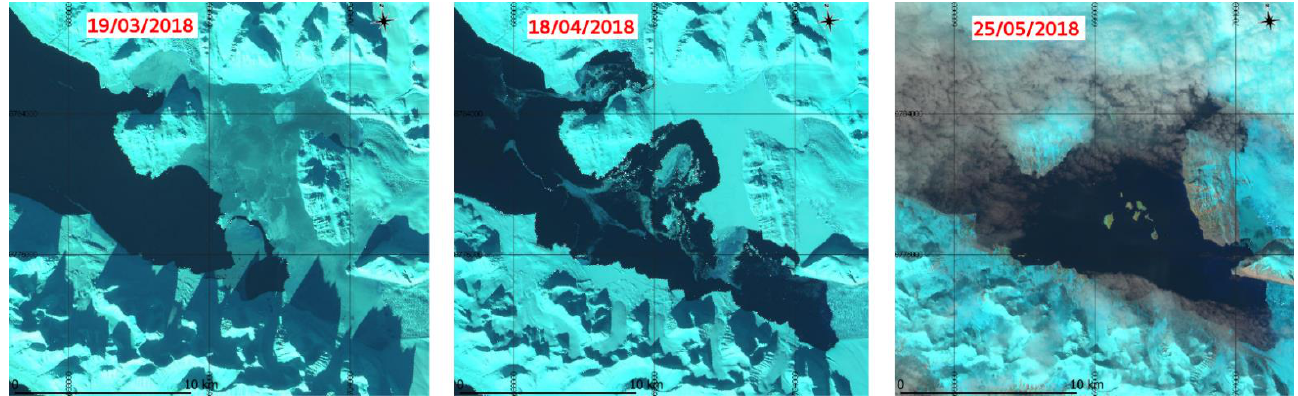
Figure 12. The three images are obtained from Sentinel 2 data and show, from left to right, the progressive melting of the fjord’s surface ice layer due to the intrusion of warmer Atlantic water. It can be seen that in March (left picture) the ice cover started to melt; subsequently it is seen that in April (central picture) the melting had already largely occurred and that at the end of May (right picture), the period in which the tests were carried out, the fjord was free from ice cover for over a month.